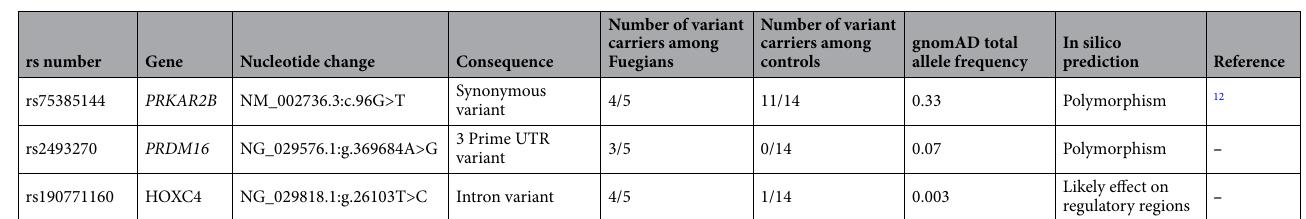
Table 1. Summary of relevant genomic variants. PRKAR2B, Protein Kinase CAMP-Dependent Type II Regulatory Subunit Beta; PRDM16, PR domain containing 16; HOXC4, Homeobox protein Hox-C4; UTR, untranslated